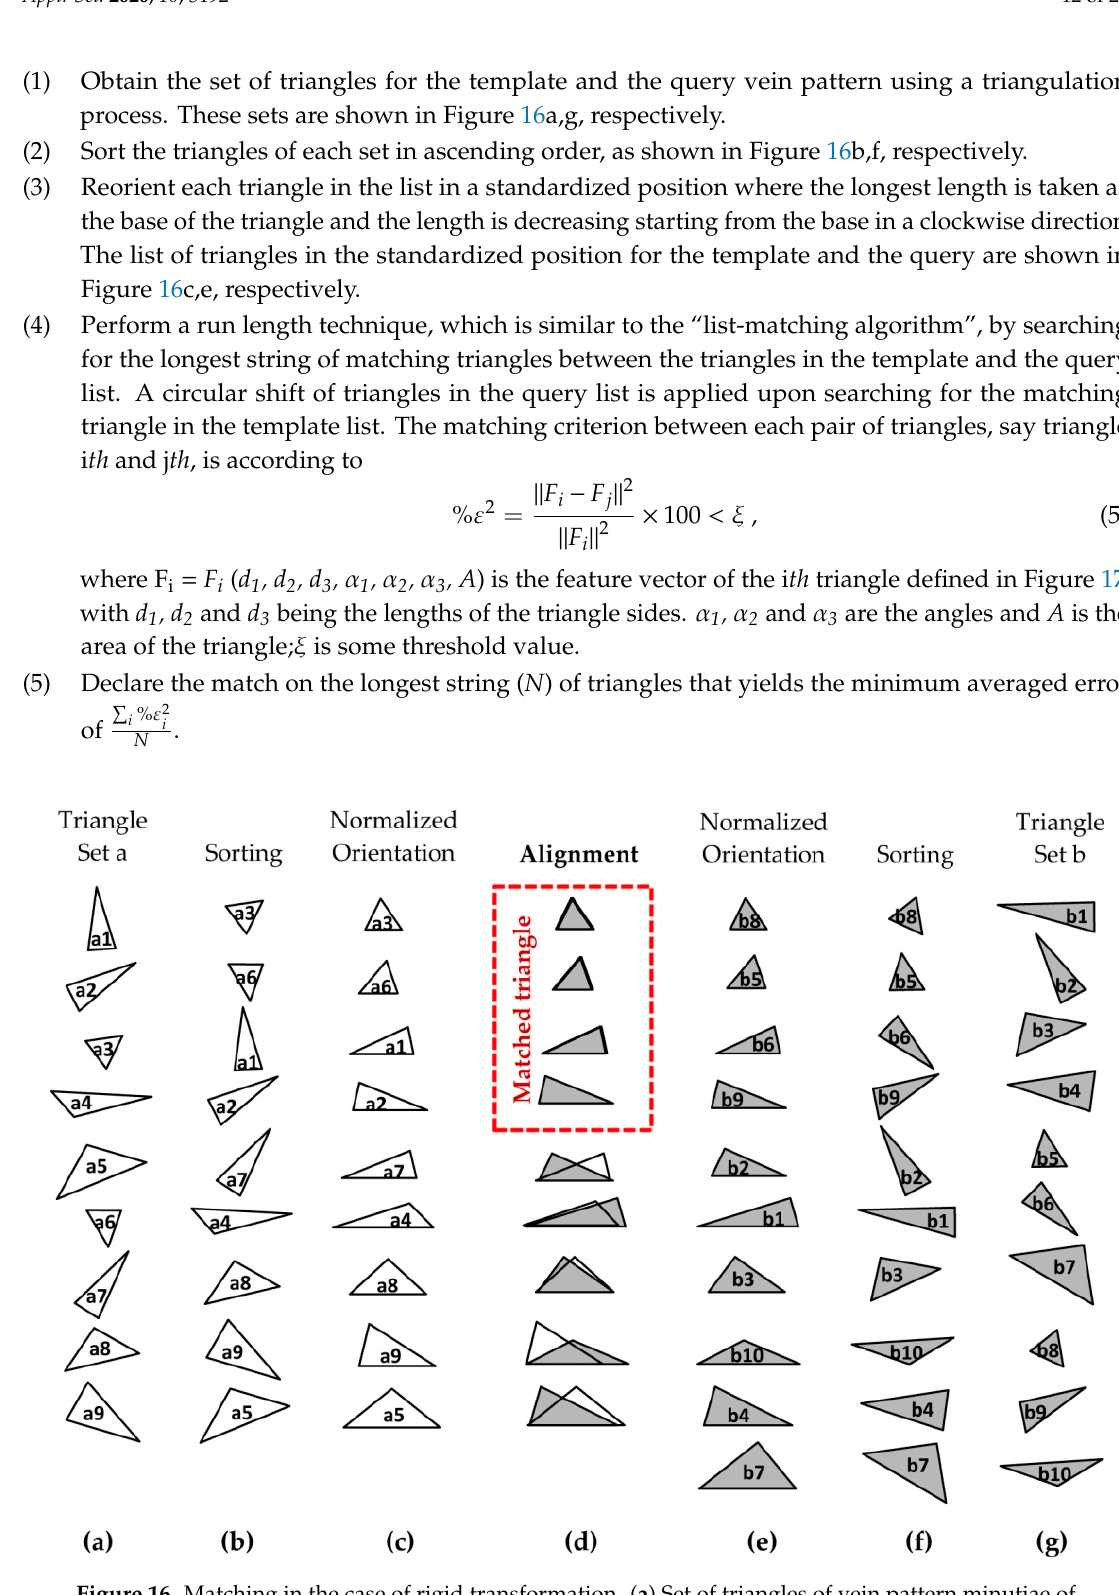
Figure 17. Definition of the parameters in feature vector F; d i is the corresponding length of triangle, α i is the corresponding angle and A is the area of triangle. 2.4.3. Matching in the Presence of Affine Transformation Under an affine transformation, the lengths and angles of the triangles are no longer preserved. Under an affine transformation, the area of the corresponding triangles, however, becomes a relative invariant, with the two corresponding areas being related to each other through the determinant of the linear transformation matrix T in the affine map transform (T, b) where b is the translation vector. If the area patches of the triangle sequence in the template are [A a (1),…,A a (n)], the corresponding area patches A(k) associated with the sequence of the triangles on the query are related to those of the template in accordance with the following relative invariant: